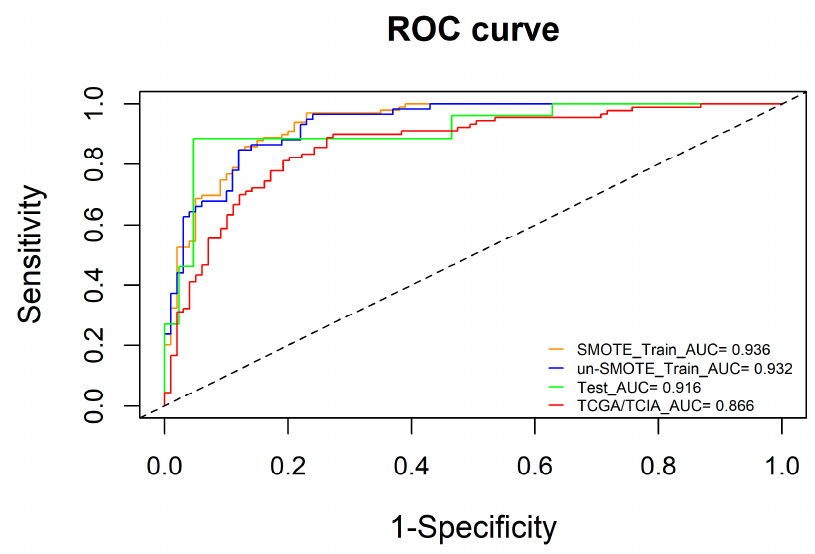
Figure 5. ROC curves of the SMOTE training cohort, un-SMOTE cohort, test cohort and independent TCGA/TCIA cohort. Table 2. Evaluation results of the radiomic model in the SMOTE training cohort, un-SMOTE training cohort, test cohort and independent TCGA/TCIA validation